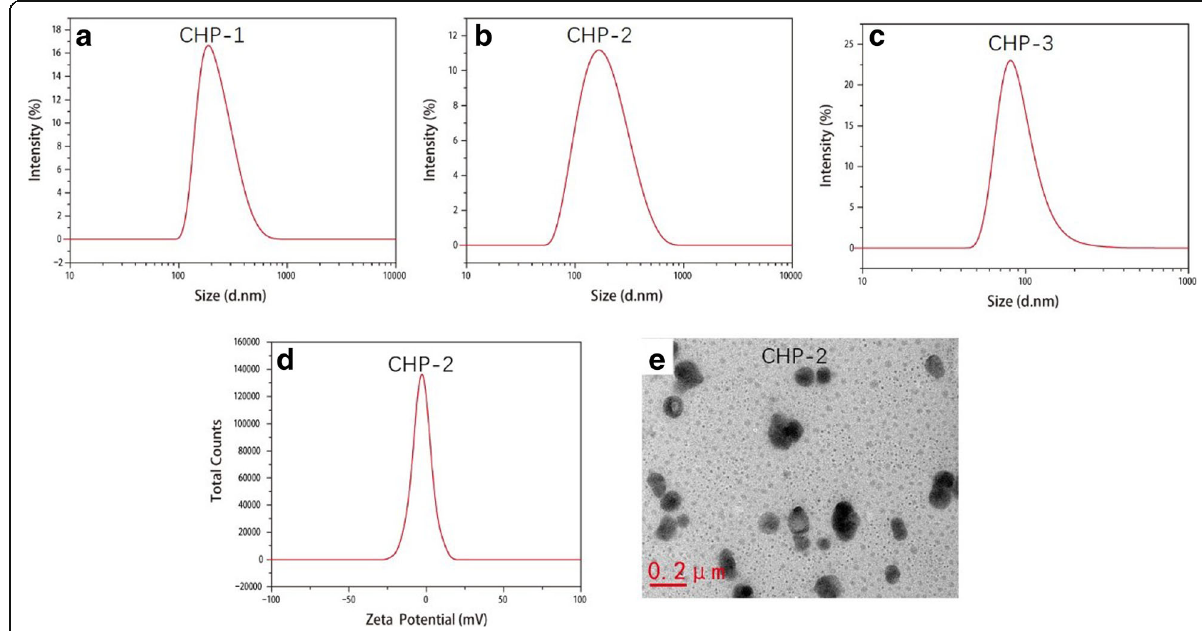
Fig. 2 Images of NP size loaded with mitoxantrone (CHP-1 ( a ), CHP-2 ( b ), CHP-3 ( c )), potential images (CHP-2 ( d )), and TEM images (CHP-2 ( e